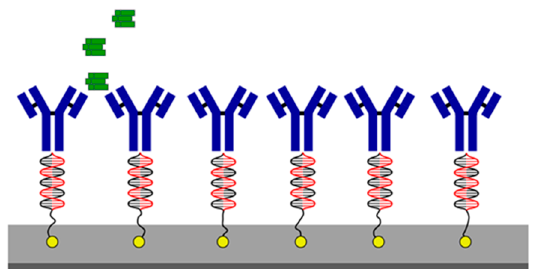
Figure 6. Schematic image of cDMAB immobilization onto titanium.